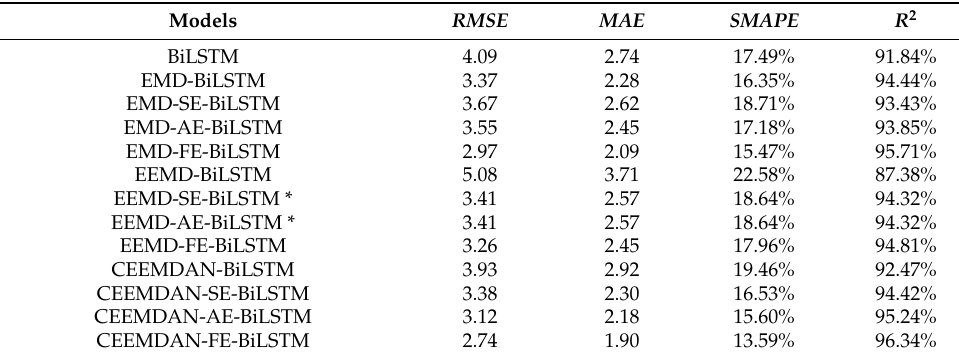
Table 3. Forecast errors of different